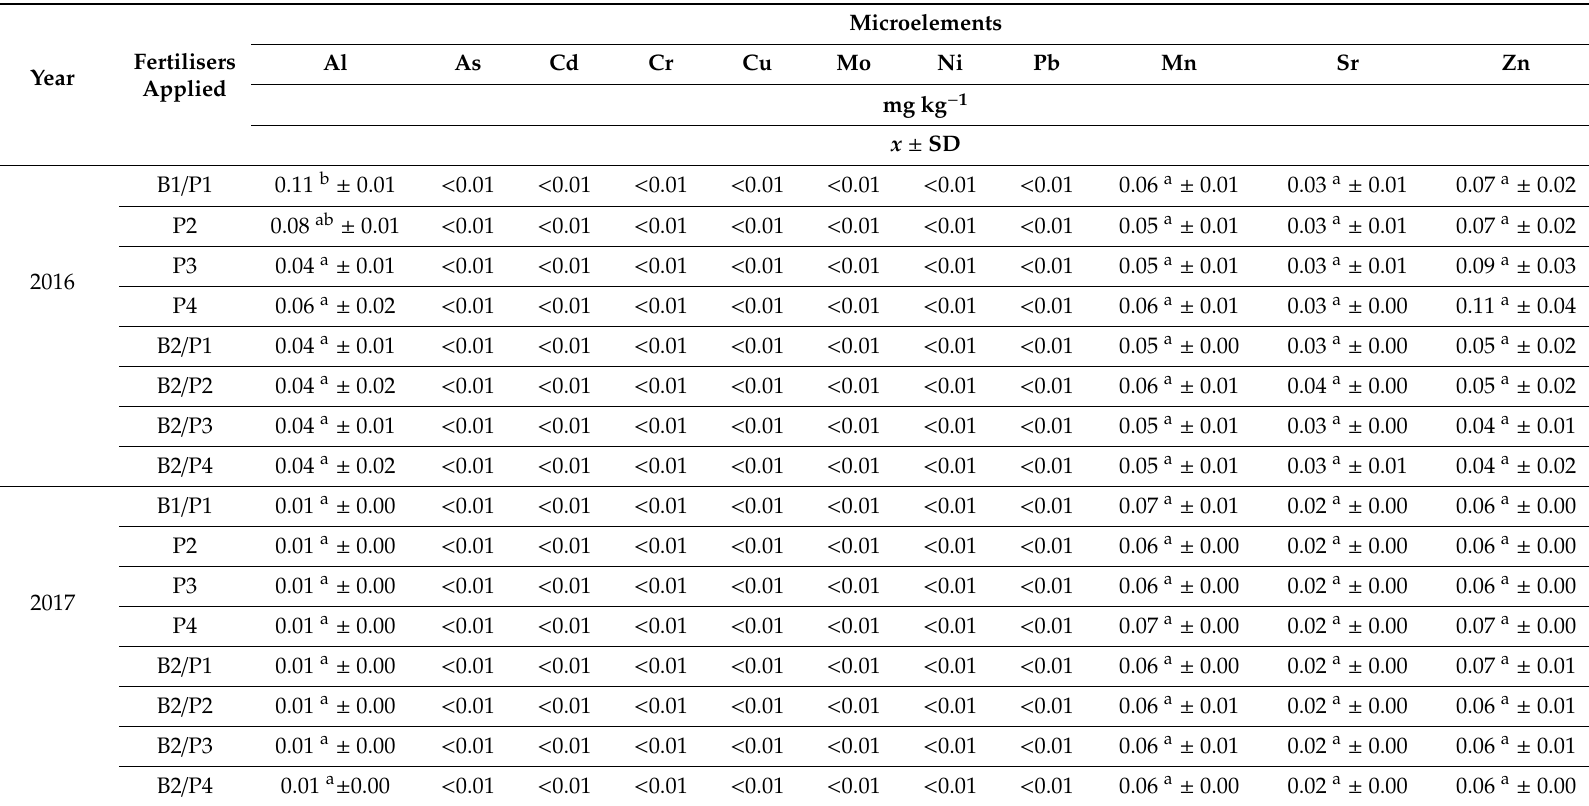
Table 8. Contents of selected micro-elements and heavy metals in basket willow biomass at the end of the first and second years of cultivation in relation to the fertilisers